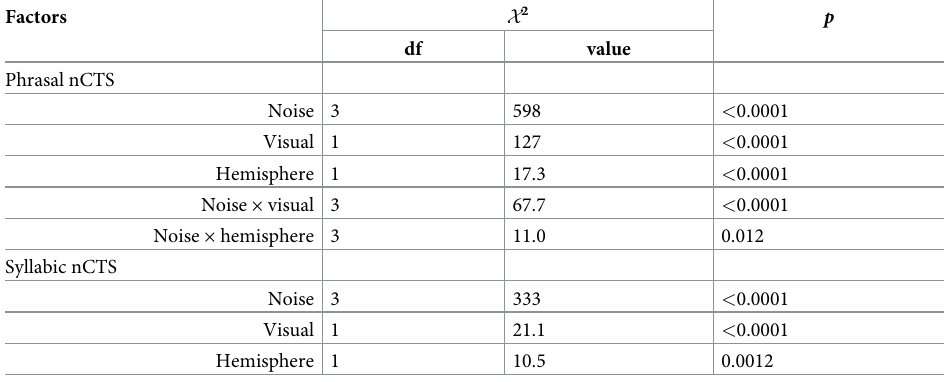
Table 2. Factors included in the final linear mixed-effects model fit to the nCTS (independent variable) at phrasal rate and at syllabic rate. Factors are listed in their order of